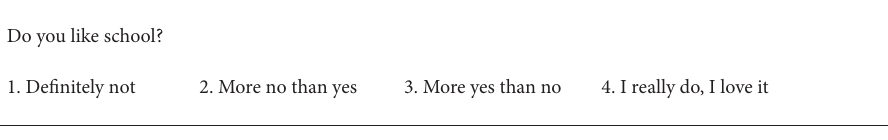
Figure 1: Example of a question on student attitudes towards school.